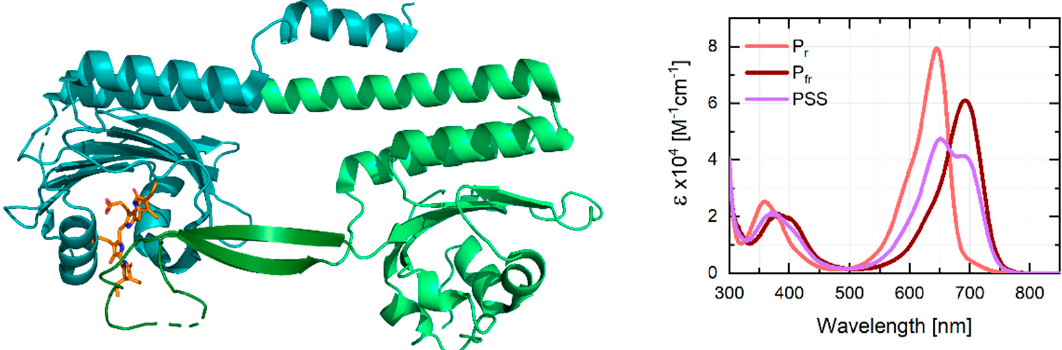
Figure 1. Left: Schematic representation of the structure of Syn Cph2 (PDB ID: 4BWI) [51]. The phycocyanobilin (PCB) chromophore (orange) is embedded in the GAF domain (cyan) interacting with a tongue-like protrusion (dark green) of the PHY domain (light green). Right: Absorption spectra of Syn Cph2 in the P r (light red) and P fr (dark red) state. To obtain the pure P fr spectrum 36% of the pure P r spectrum (factor determined by visual inspection of the resulting spectrum) was subtracted from the photostationary state (PSS) spectrum (purple), followed by multiplication with a factor of 1.56 to simulate full conversion to the P fr state (as done previously [50]). Fluorescence spectra of the P r state and a fluorescence quantum yield of 3.2% were reported previously while no fluorescence was observed for the P fr state [13].